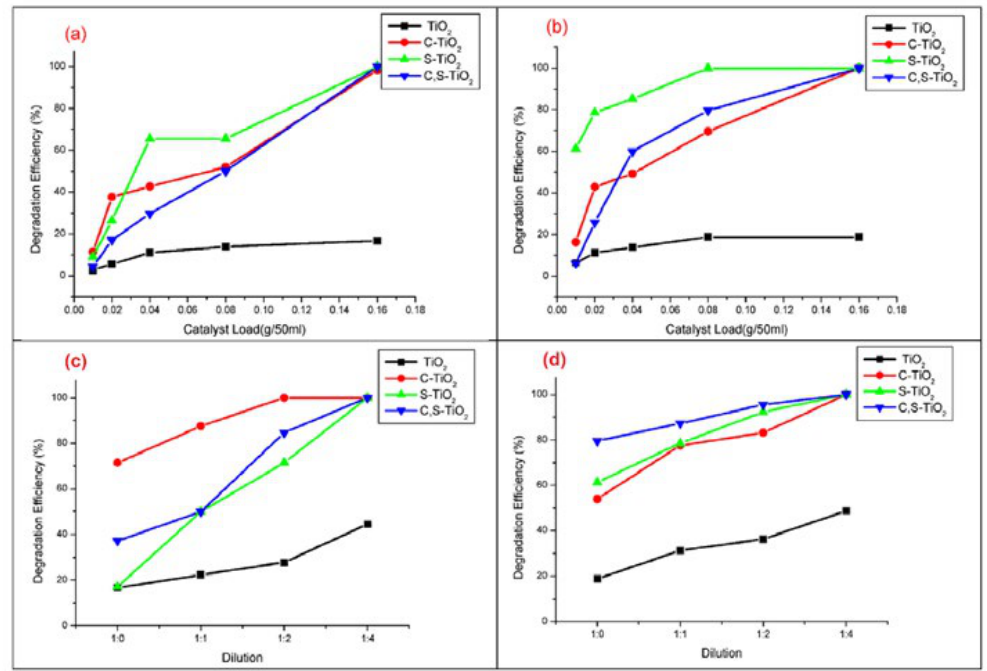
Fig. 7: Effect of photocatalyst load RB-19 (a) and of RR-76 (b) and Effect of organic matter concentration in wastewater RB-19 (c) and of RR-76 (d) on the degradation efficiency of present in industrial wastewater using TiO 2 , C-TiO 2 , S-TiO 2 and C,S-TiO 2 NPs as photocatalysts